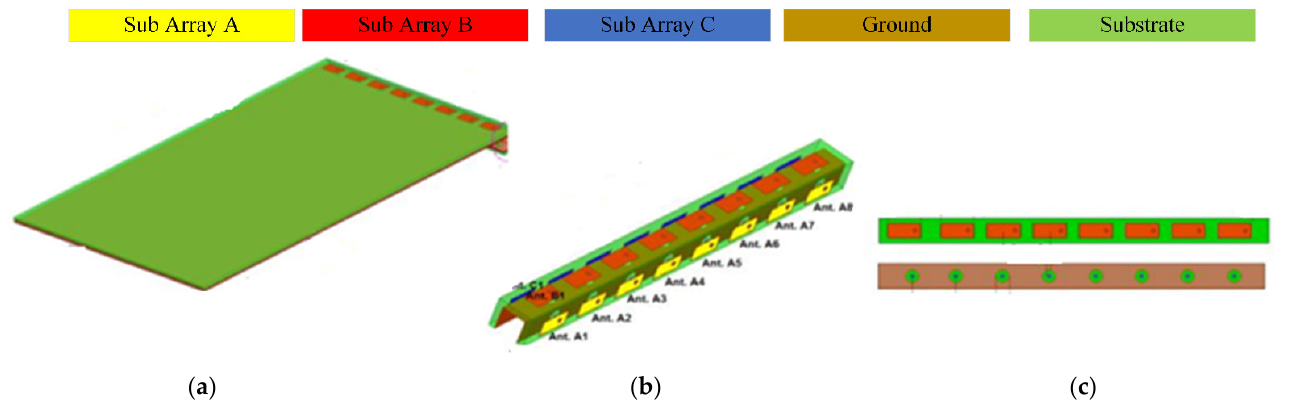
Figure 8. Switchable phased arrays ( a ) side view with full PCB, ( b ) 3 antenna arrays, and ( c ) top and bottom view of one array [13].